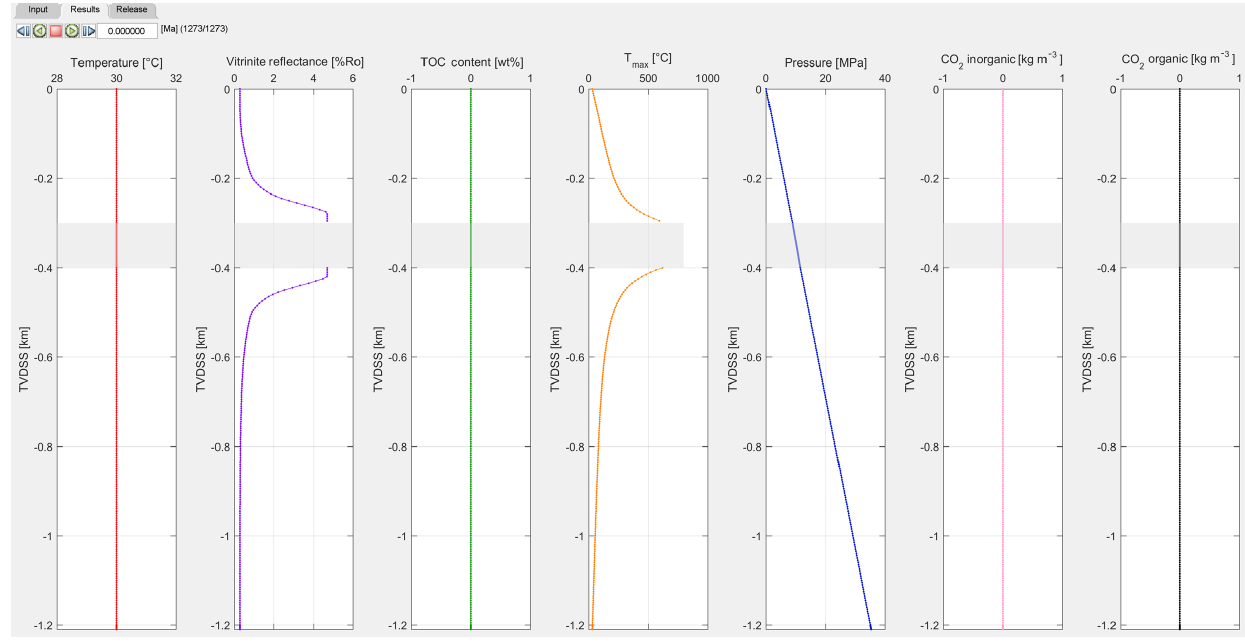
Figure 13. Results tab at the end of the simulation time for the pluton example. VR and TOC data are not present for this hypothetical case.